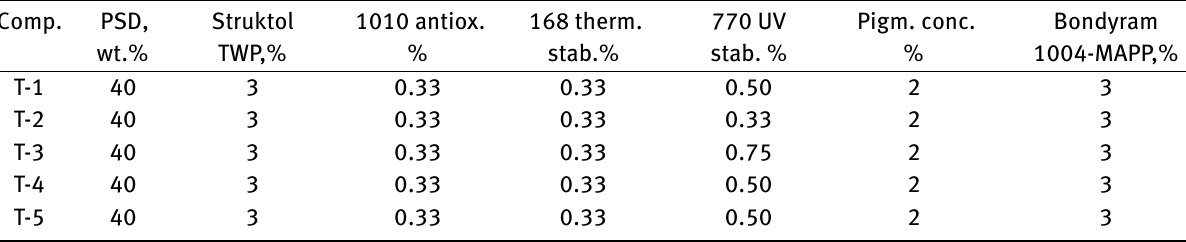
Table 1: Composition of WPCs based on polypropylene + 40 wt.% birch plywood sanding dust (PSD)